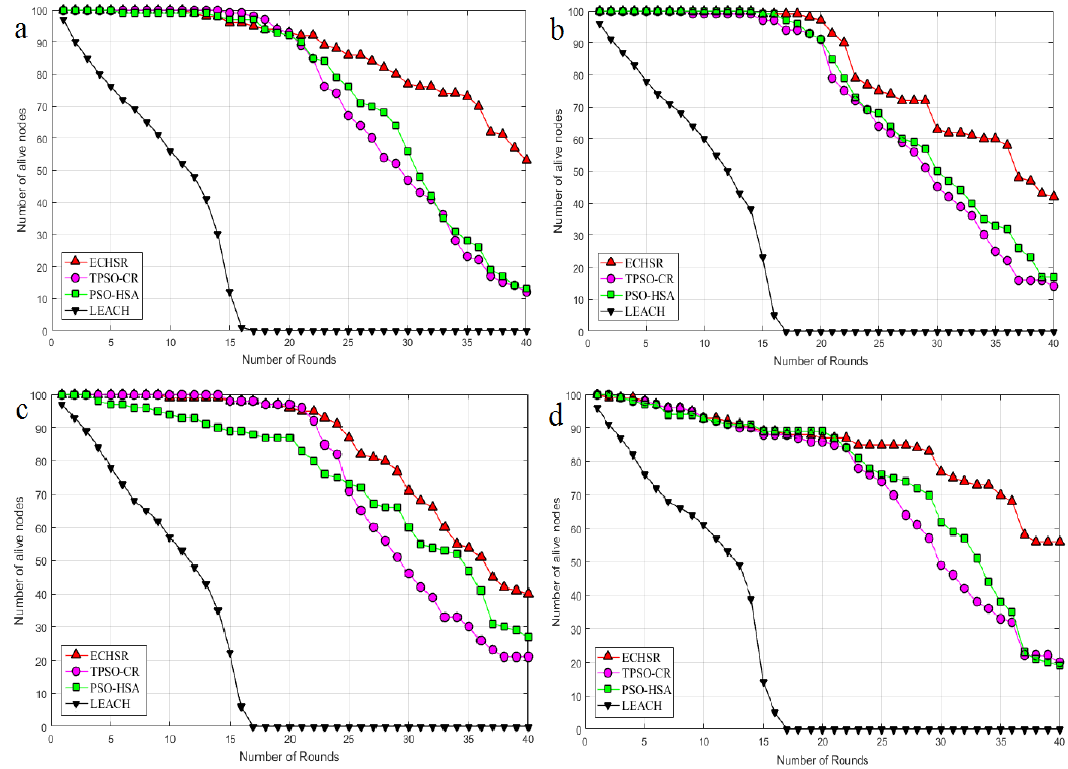
Figure 10. The number of live nodes for sink locations ( a ) (100, 100), ( b ) (0, 100), ( c ) (50, 150), and ( d ) (50, 200).